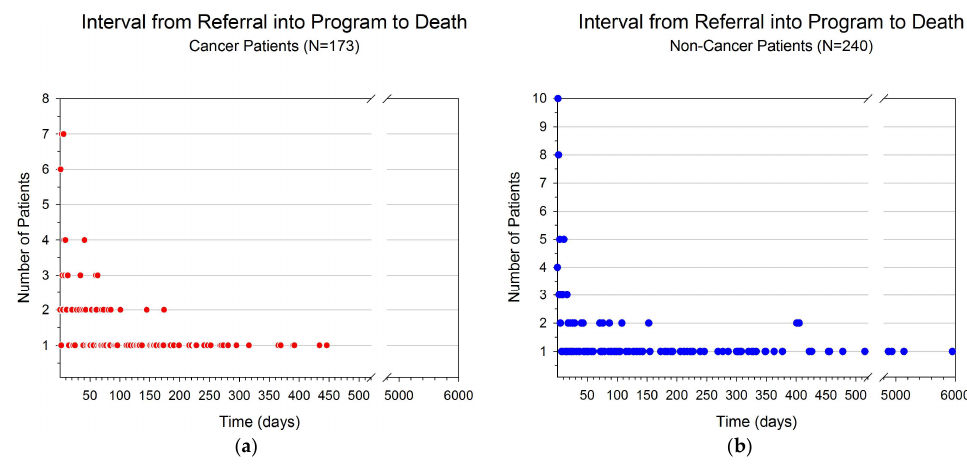
Figure 2. ( a ) Intervals from referral to palliative care until death for cancer patients; ( b ) Intervals from referral to palliative care until death for patients with non-cancer conditions.